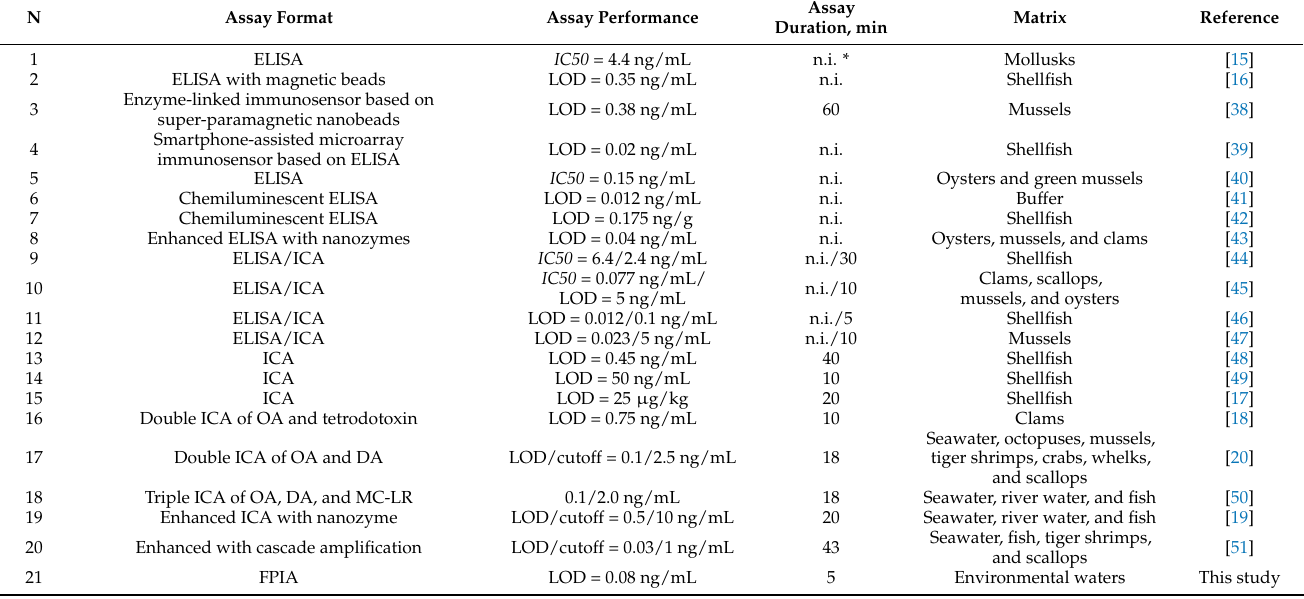
Table 2. Studies on the ELISA, ICA, and FPIA of